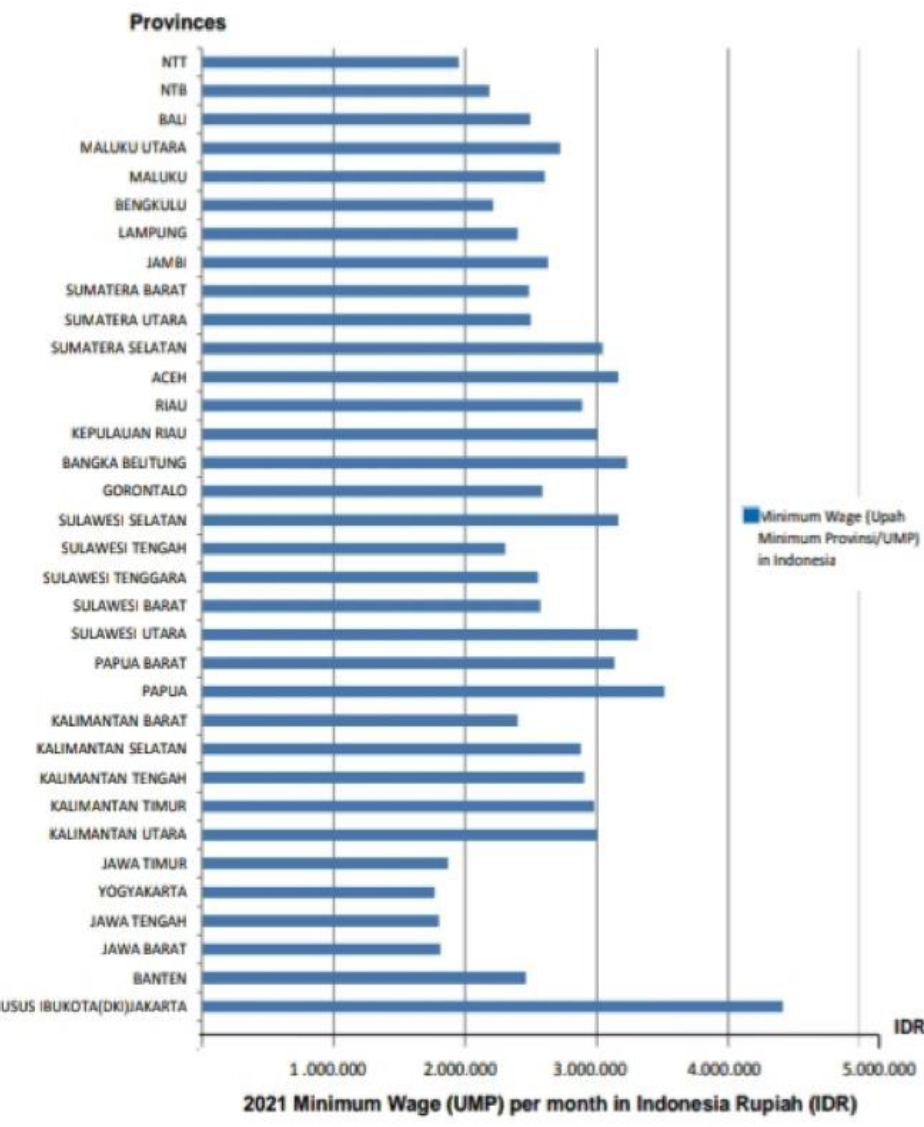
Table 2: The Decrees of the Governors in 34 Provinces in Indonesia regarding the 2021 Minimum Wage (Upah